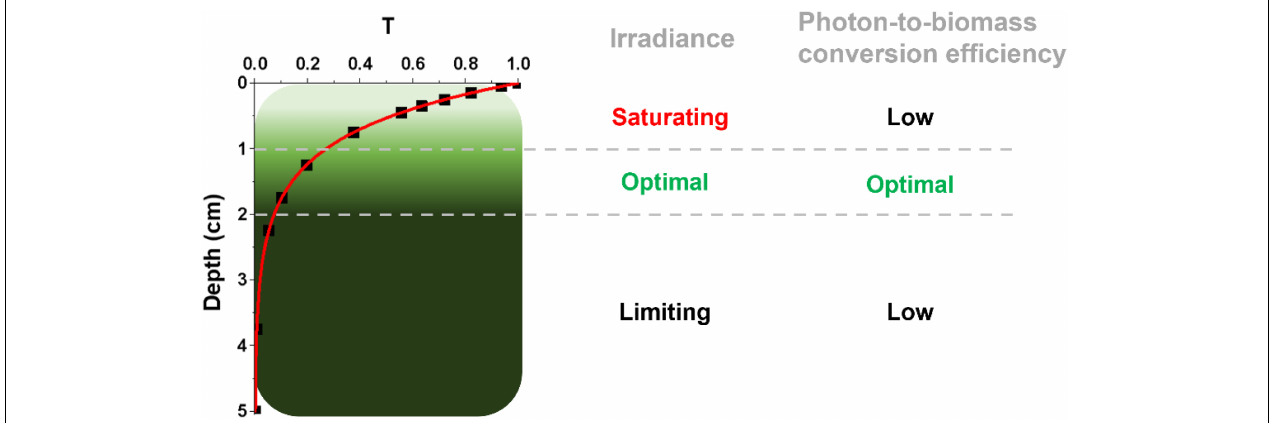
FIGURE 1 | Light distribution in a dense microalgal culture. The light attenuation profile is here expressed as transmittance (T), namely the ratio between transmitted and incident light, and it is described as a function of the depth of the photobioreactor (in centimeters, cm), using experimental data from a Nannochloropsis gaditana culture at 1 g L − 1 concentration in a PBR with a 5-cm depth (Perin et al., 2017b). According to this light attenuation profile, three different regions within the PBR can be identified, distinguished for their irradiance and photon-to-biomass conversion efficiency profiles, as described on the right. It is worth noting that the culture layers more distal from the light source (from the top in this case) have a potential high photon-to-biomass conversion efficiency, which is however not achieved because of the limiting light they